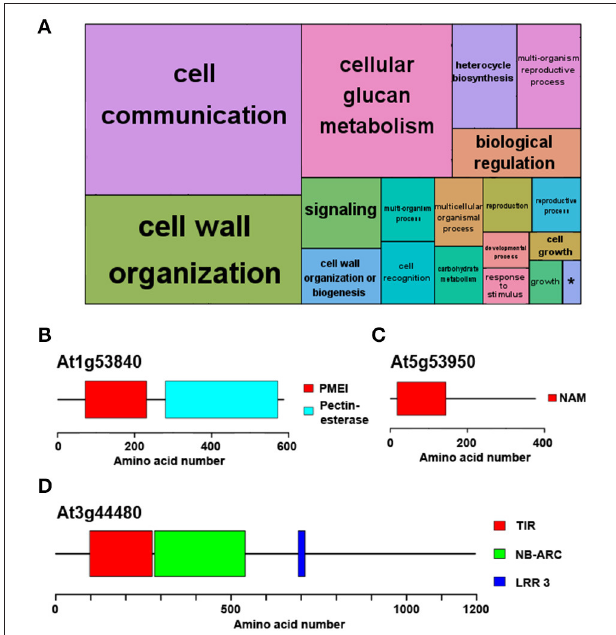
FIGURE 3 | Functional annotation of genes exclusively identified in Arabidopsis . No potential Chlamydomonas or Ostreococcus orthologues were identified for a quarter of Arabidopsis proteins. (A) Non-redundant GO term enrichment analysis over the set of Arabidopsis -specific genes suggests that they are mainly involved in “ cell communication/signaling ,” “ cell wall organization ,” “ cellular glucan metabolism ” and “ multiorganism reproductive process. ” (*) “s ingle-organism developmental process. ” Each rectangle area in the treemap represents the log10 ( p -value) for the corresponding GO-term. − (B) Domain structure of the protein encoded by Pectin Methylesterase 1 , ( PME1, At1g53840), an example of an Arabidopsis specific protein involved in “ cell wall organization and glucan metabolism. ” (C) An instance of an Arabidopsis specific protein annotated with “ multi-organism reproductive process ” is the protein encoded by NAC domain containing protein 98 ( ANAC098, At5g53950) involved in floral development. (D) Domain structure of the protein encoded by Recognition of Peronospora Parasitica 1 ( RPP1, At3g44480), one of the specific Arabidopsis proteins involved in “ cell communication/signaling. ” Color boxes represent domains identified in pfam database including their identification